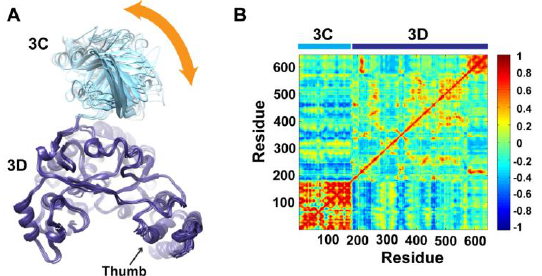
Figure 4. Conformational changes of 3CD during simulations. ( A ) Representative conformations of the clusters (1–6) sampled during the last 50 ns of wild-type (WT) 3CD simulation of monomer 1, superimposed using Cα atoms of 3D-domain. The positioning of 3C-domain (cyan) relative to 3D-domain (blue) varies among the different conformations, resulting in small variations at the interface between the two domains as indicated by the orange arrow. ( B ) Dynamic Cross-Correlation Map (DCCM) analysis of the last 50 ns, calculated for Cα atoms of all residues in 3CD. Residues of 3C-domain exhibited strong correlations, indicating rigid-body motion of the domain. Also, residues of the thumb (aa 563–644) in the 3D-domain showed strong correlations; which is consistent with the slightly larger deviations observed for the thumb residues shown in ( A ).